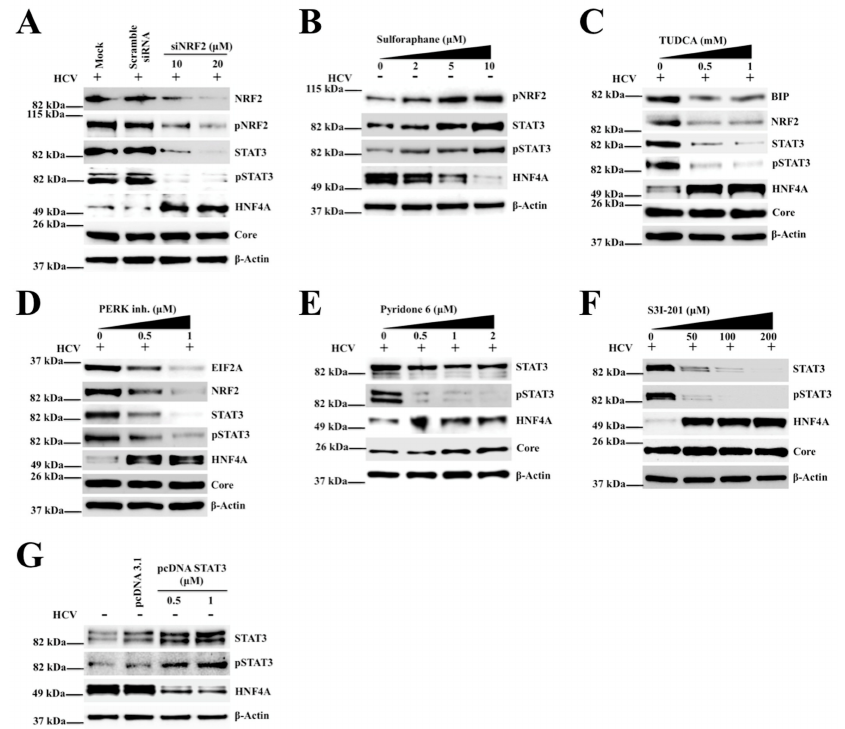
Figure 3. Shown is the nuclear factor erythroid 2-related factor 2 (NRF2)-dependent regulation of signal transducer and activator of transcription 3 (STAT3)-hepatocyte nuclear factor 4 alpha (HNF4A) expression in hepatitis C infection (HCV) infection. ( A ) The e ff ect of NRF2 silencing on the expression of STAT3-HNF4A in HCV culture. Infected Huh-7.5 cells on day 9 were treated with combination of two small interfering RNAs (siRNAs) targeted to NRF2 and scrambled siRNA and the expression of STAT3 and HNF4A was measured by Western blot analysis after 72 hours. The e ff ect of siRNA transfection did not alter HCV core expression or expression of β -Actin levels. ( B ) Shown is the e ff ect of treatment with the NRF2 activator, sulforaphane, on the expression of STAT3 and HNF4A in uninfected Huh-7.5 liver cells. ( C) Western blot analysis shows the e ff ect of the endoplasmic reticulum (ER) stress inhibitor (TUDCA) on the expression levels of STAT3 and HNF4A in HCV-infected culture. ( D ) Shown are the expression levels of STAT3-HNF4A in HCV culture treated with the protein kinase RNA-like ER kinase (PERK) inhibitor by Western blot analysis. ( E ) Shown is the e ff ect of the Janus kinase (JAK) inhibitor on the phosphorylation of STAT3 and HNF4A regulation. ( F ) Shown is the e ff ect of the STAT3 inhibitor on the expression levels of HNF4A in infected cells by Western blot analysis. ( G ) The e ff ect of STAT3 over expression by plasmid transfection on the levels of HNF4A in uninfected Huh-7.5